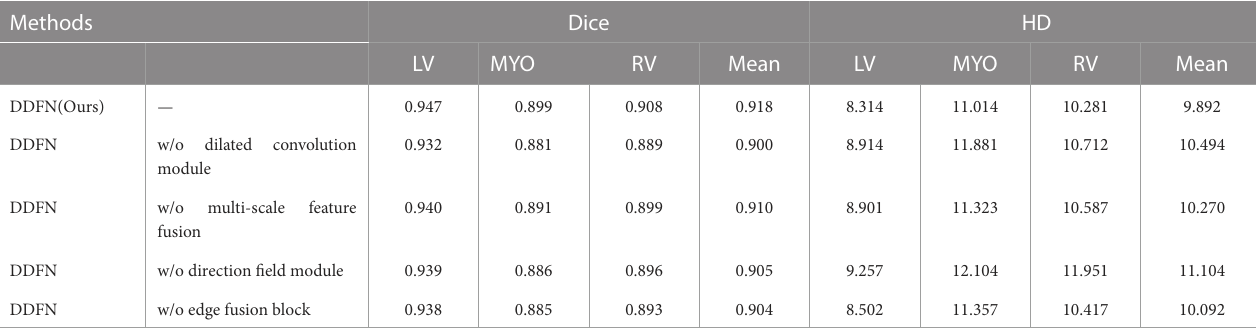
TABLE3 Dice/HDofourmethodsonACDCdataset. Methods